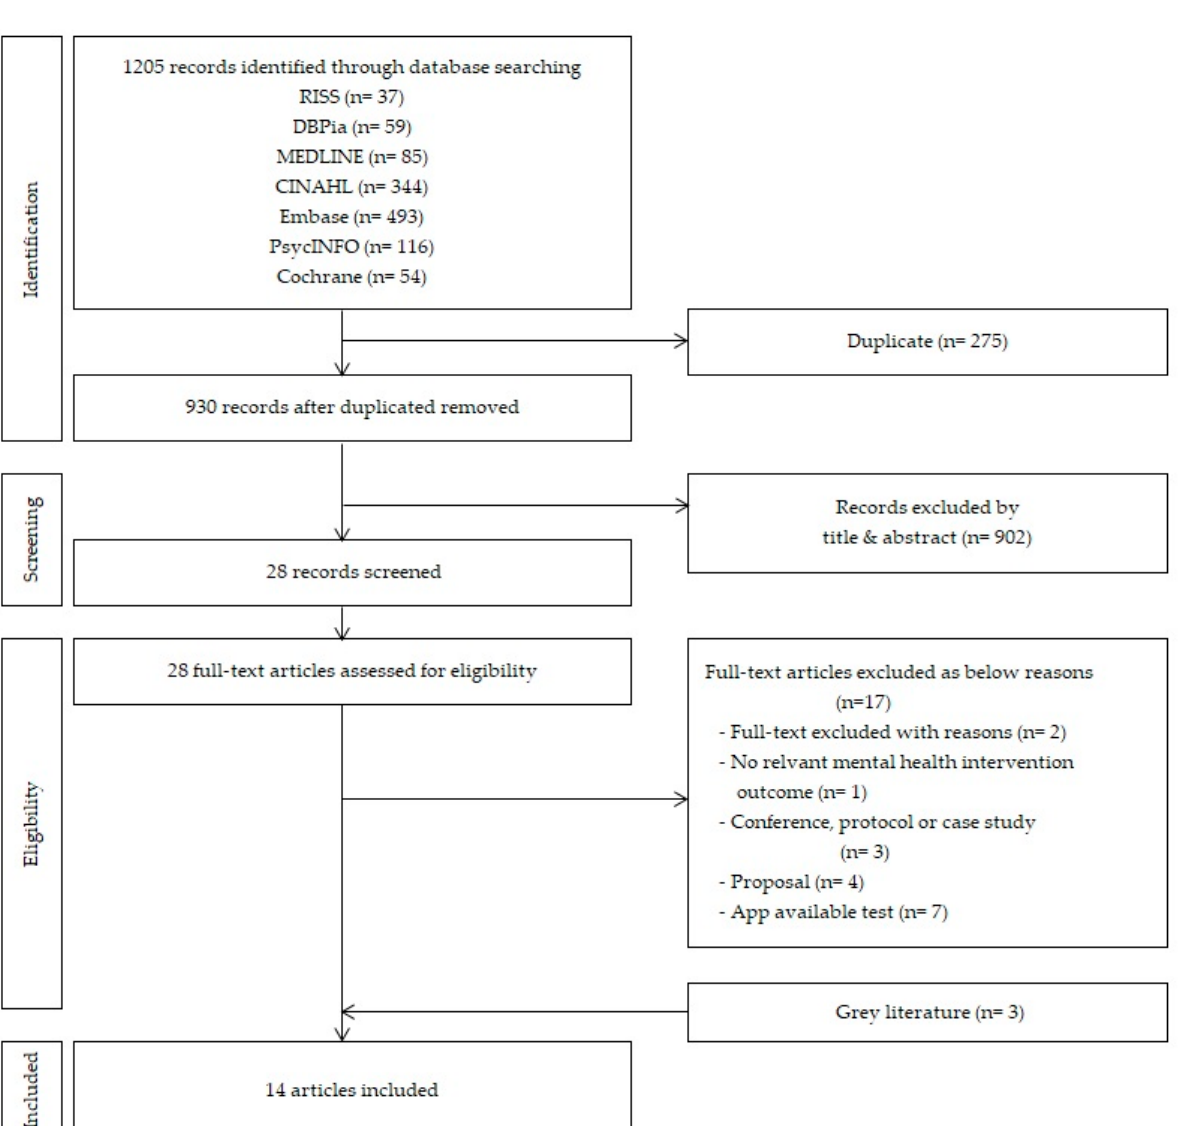
Figure 1. Flow diagram of the study selection processes for scoping review.